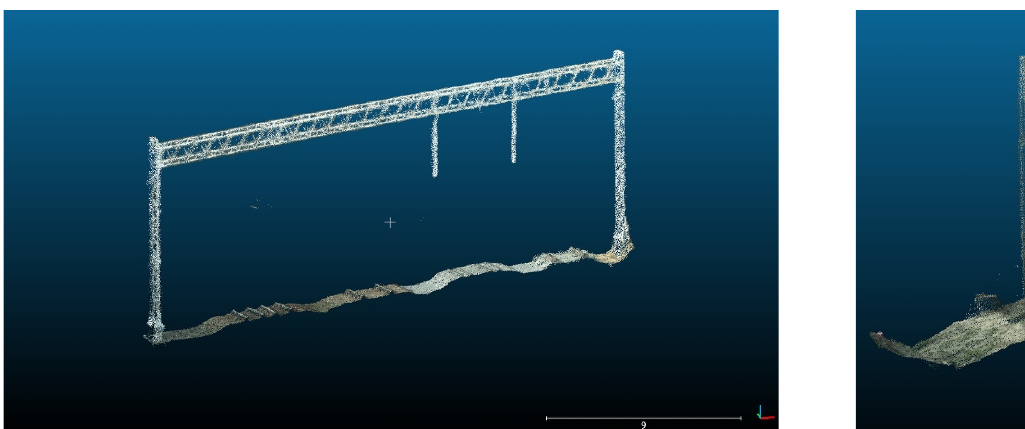
Figure 4 . Examples of objects cut from a point cloud.